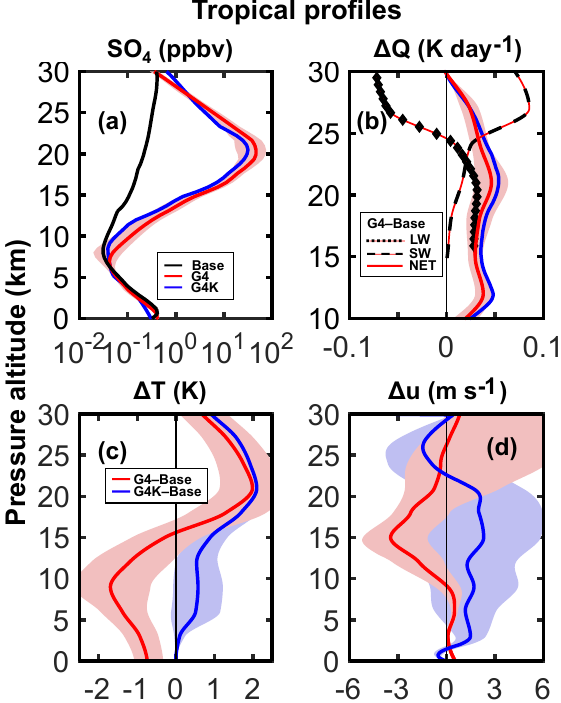
Figure 9. Average tropical vertical profiles (25 ◦ S–25 ◦ N; years 2030–2069) of the SO 4 volume mixing ratio for the G4, G4K and Base experiments (ppbv, panel a ); G4–Base changes of net, short- wave and longwave heating rates (Kday − 1 , panel b ) (LW is cal- culated with temperature fixed at Base values) (net heating rate changes are also shown for G4K–Base, with the blue line); G4– Base and G4K–Base temperature changes (K, panel c ); G4–Base and G4K–Base changes of mean zonal winds (ms − 1 , panel d ). The shaded areas of the same color represent ± 1 σ for the ensemble over the 40-year period from 2030 to